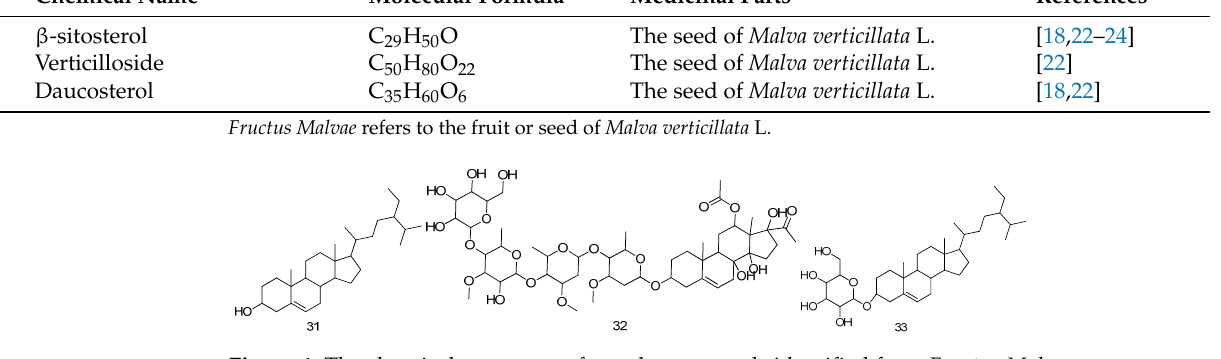
glucopyranosyl-2,3-di-O-linolenoyl glyceride (compounds 38 , 39 ) are two sulfoquinovosyl